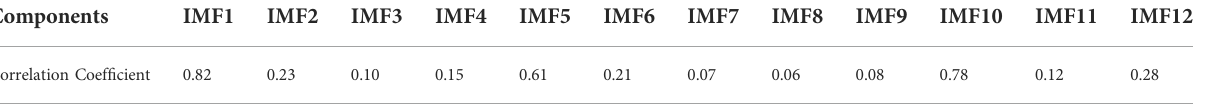
TABLE 1 The correlation coef fi cient between the observed time series and the decomposed components. Components